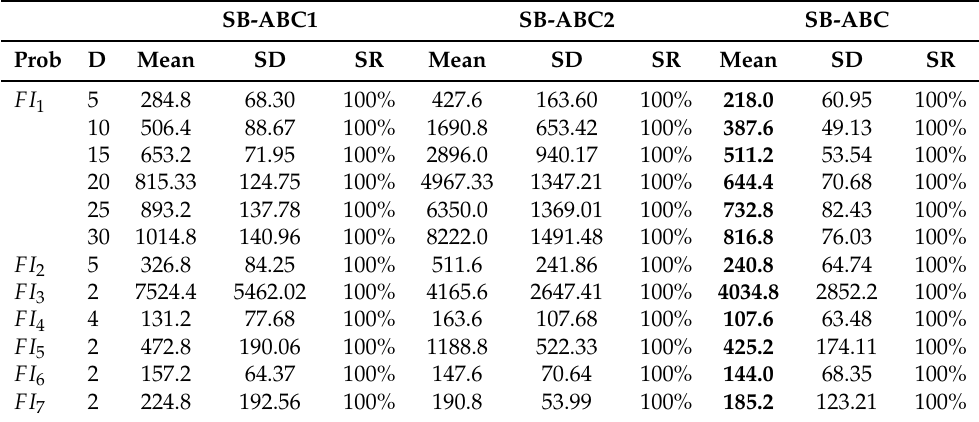
Table 8. Comparison results of the SB-ABC1, SB-ABC2 and SB-ABC for the FI 1 – FI 7 integer program-